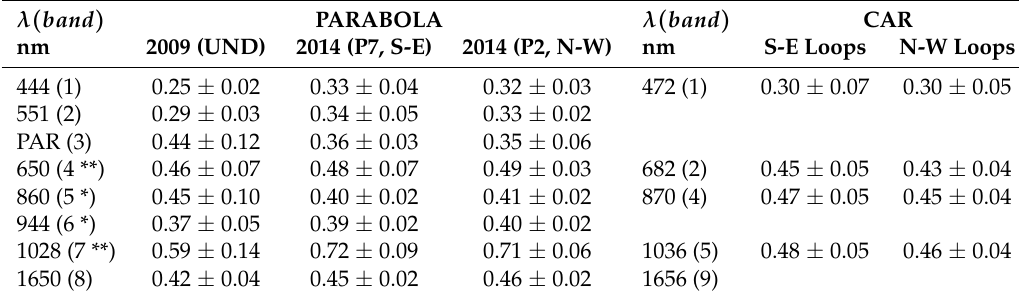
Table 2. Average and standard deviation of the hemispherical-directional reflectance factor (HDRF)